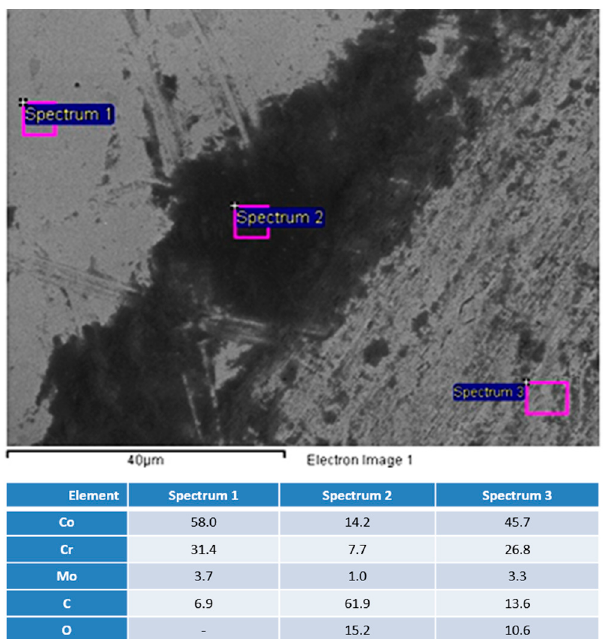
Figure 4. HCCoCr surface after wear corrosion applying anodic potentiodynamic polarization. Secondary electron image and EDS analyses away from the track, in the immediate vicinity, and inside the track in the HCCoCr surface in PBS-HA+POL.